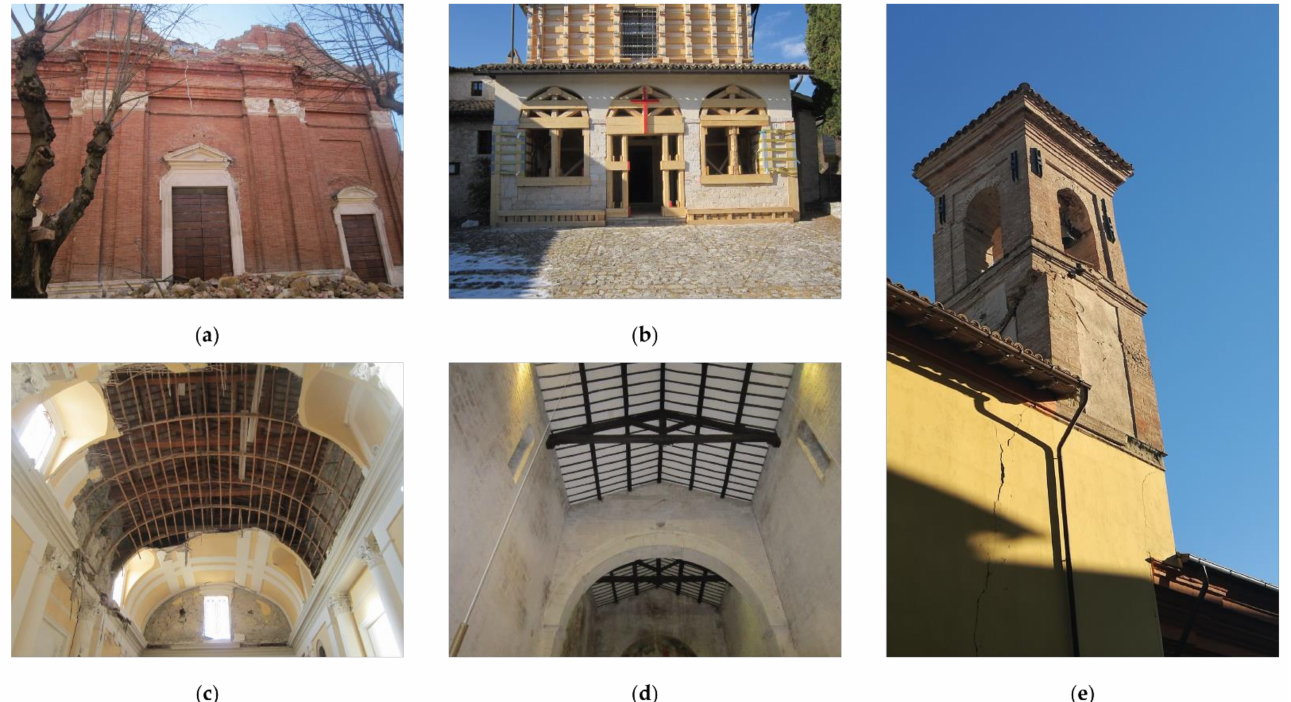
Figure 2. Examples of activation or collapse related to damage mechanisms during 2016-2017 Central Italy earthquake: ( a ) overturning of top façade in San Filippo church (Camerino, MC), ( b ) damage in the prothyrum in Santa Maria di Costantinopoli church (Cerreto di Spoleto, PG), ( c ) vault collapse in Santa Chiara Monastery (Camerino, MC), ( d ) triumphal arch damage in SS Felice and Mauro Abbey (Sant’Anatolia di Narco, PG), and ( e ) severe damage in the bell tower of San Carlo church (Camerino, MC).